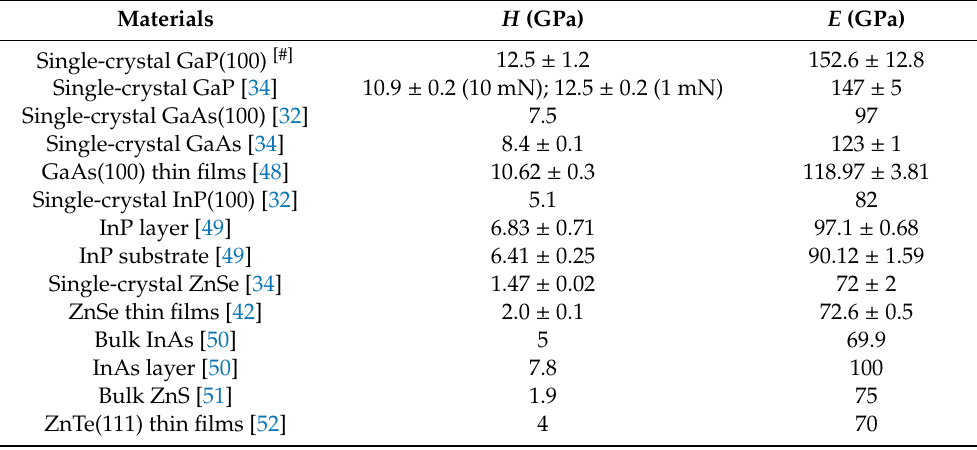
Table 1. The hardness and Young’s modulus of various semiconductor